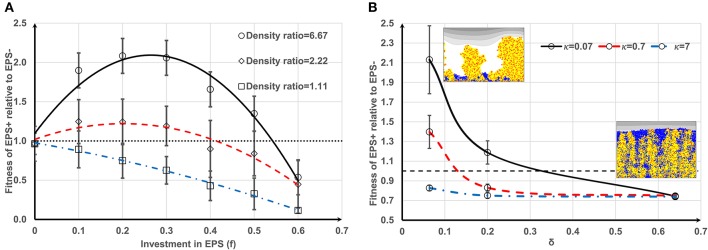
Effect of different parameters on the fitness of EPS+: (A) Fitness of EPS+ strain relative to EPS− strain as a function of investment in EPS (f) and biomass to EPS density ratio (ρ/ρEPS). It is seen that if the density ratio is high it is advantageous for EPS+ strain and also there would be an optimum f-value which gives the maximum benefit for EPS+ strain. If the EPS density is relatively low, EPS+ cells are easily outcompeted by EPS− cells since EPS+ cells cannot push their progeny fast into the nutrient rich upper levels. The lines are the polynomial fits to the corresponding data points and the error bars indicate the standard deviations; (B) relative fitness of EPS+ strain relative to EPS− strain as a function of δ and κ which are two non-dimensional parameters appeared in the nutrient transport equation. It is clear that EPS+ are not beneficial at high values of δ and κ since the heterogeneity of nutrient concentration is less in this case and hence both strains are mixed in the biofilms rather than making own lineages. The lines are the polynomial fits to the corresponding data points and the error bars indicate the standard deviations.